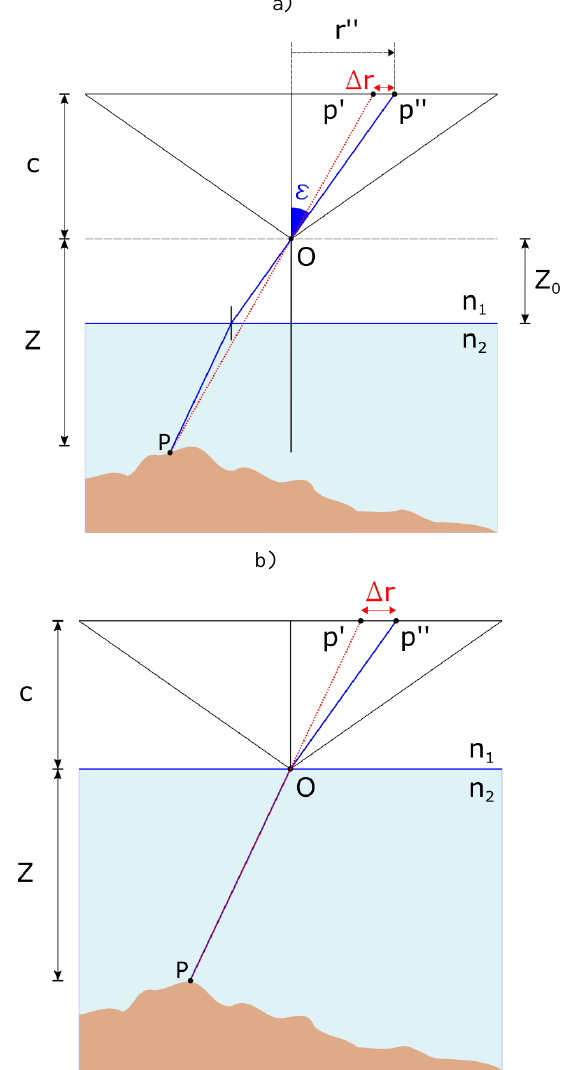
Figure 2. Schematic representation of a pinhole camera observing a submersed scene trough a flat separation surface. The 2 figures differ for the position of the centre of perspective (entrance pupil, O ) located respectively above (a) and on (b) the separation surface